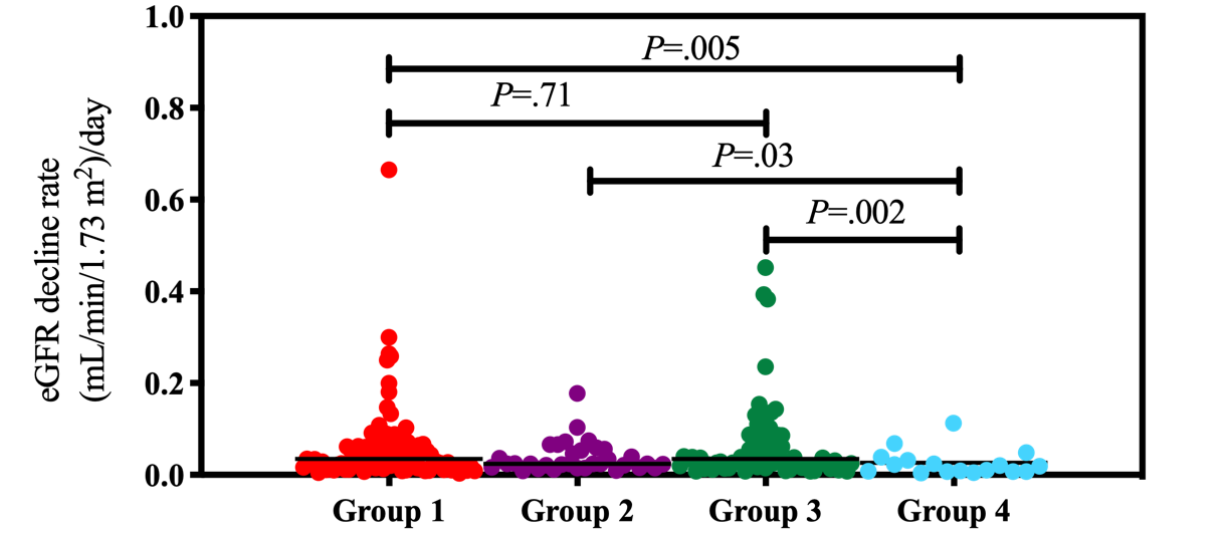
Figure 2. Trends in the decline of daily estimated glomerular filtration rate (eGFR; [mL/min/1.73 m 2 ]/day) were compared between the four groups. The lines indicate median values. Statistical calculation of P values was performed using the nonparametric Mann-Whitney U test.